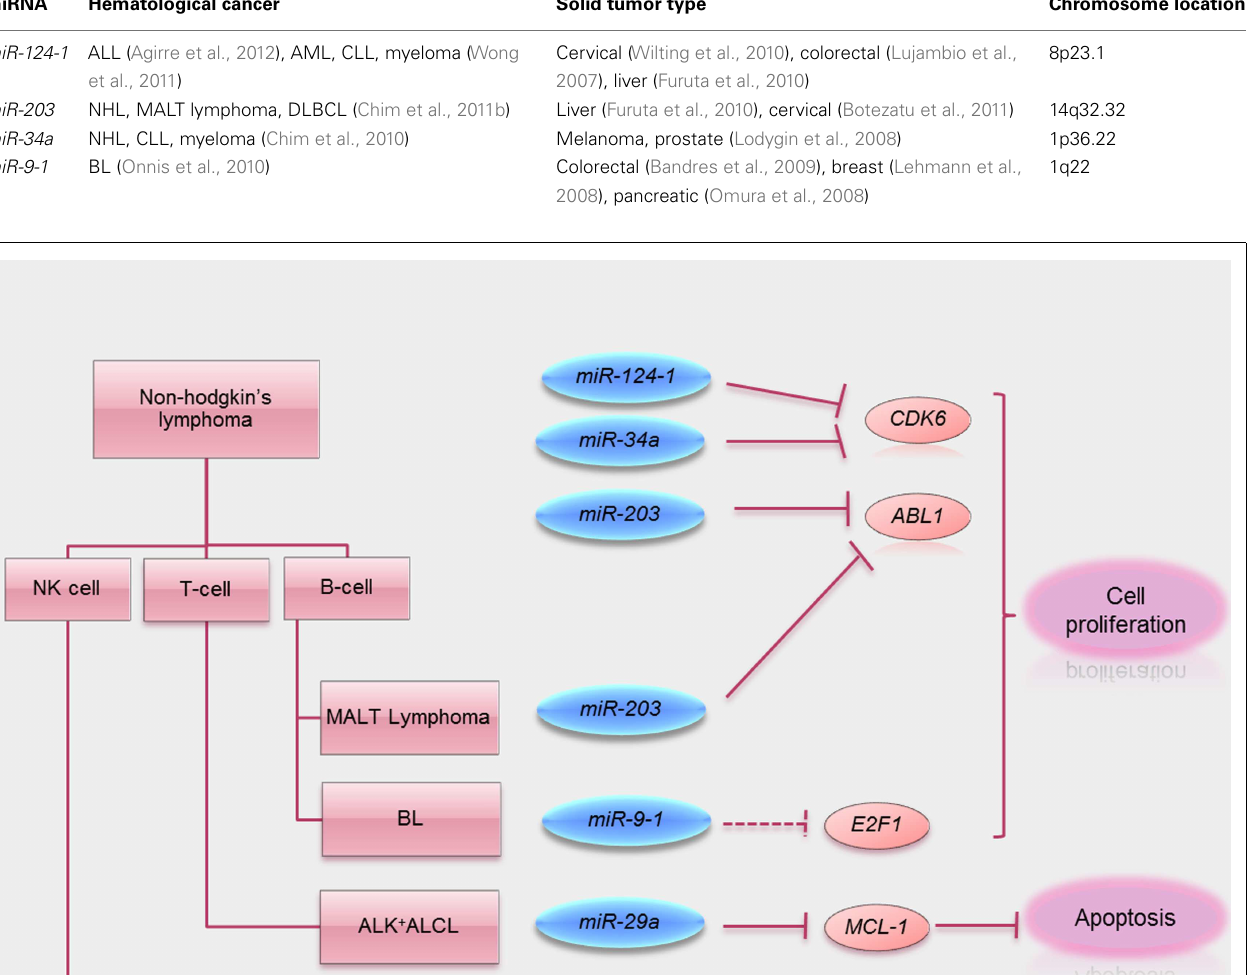
FIGURE 2 | Summary of tumor suppressive functions of miRNA methylated in lymphoma. Schematic visualization summarizing miRNA methylated in different subtypes of lymphomas known direct target